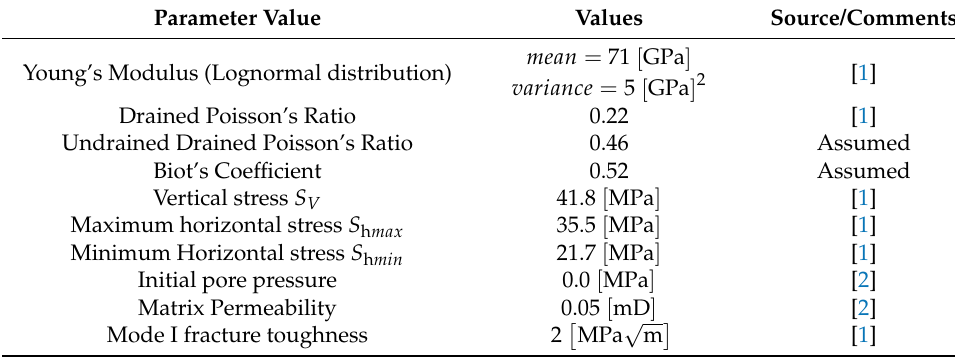
Table 1. Reservoir properties used in the